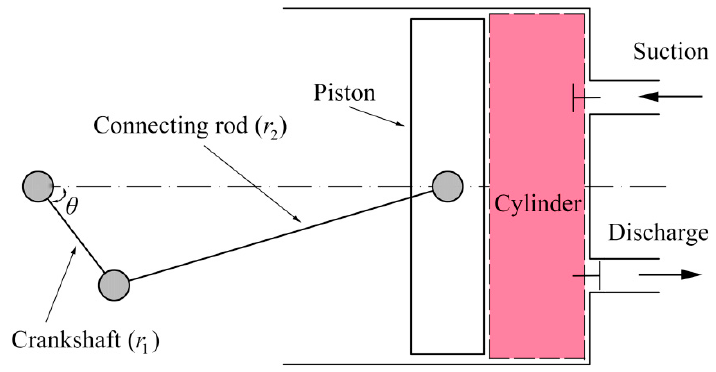
Figure 1. Schematic of reciprocating compressor sub-model.